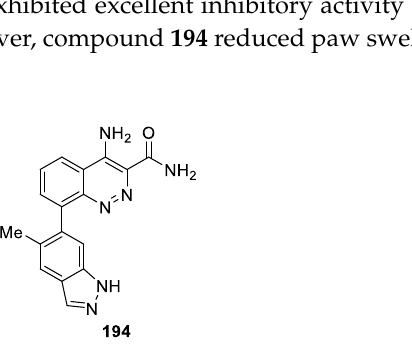
Figure 66. Chemical structure of 1 H -indazole derivative 193 .